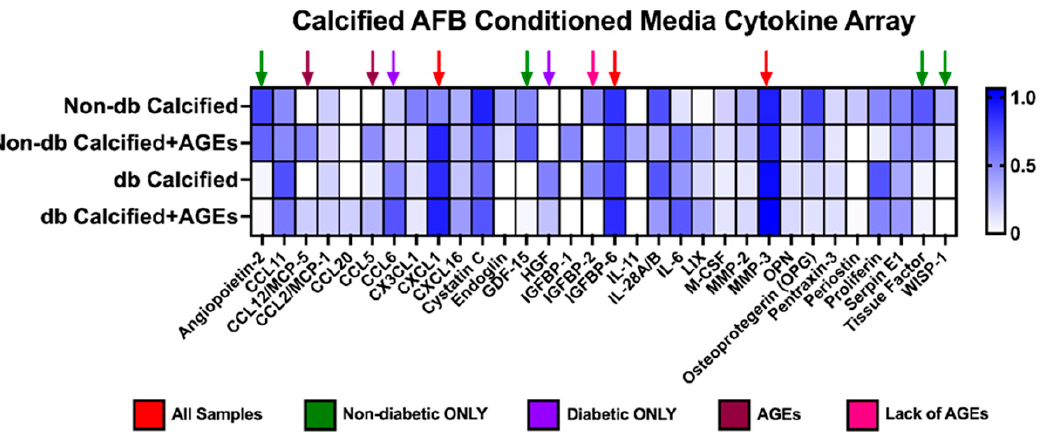
Figure 5. Calcified AFBs-conditioned media from non-diabetic and diabetic cells released different cytokines, chemokines, and proteins. Pooled calcified AFBs-conditioned media ( n = 3–4) was utilized for a cytokine array kit and manufactured instructions were followed. Densiometric analysis was used for each spot and normalized to the average of the reference spots for each membrane. No statistical analysis was performed.